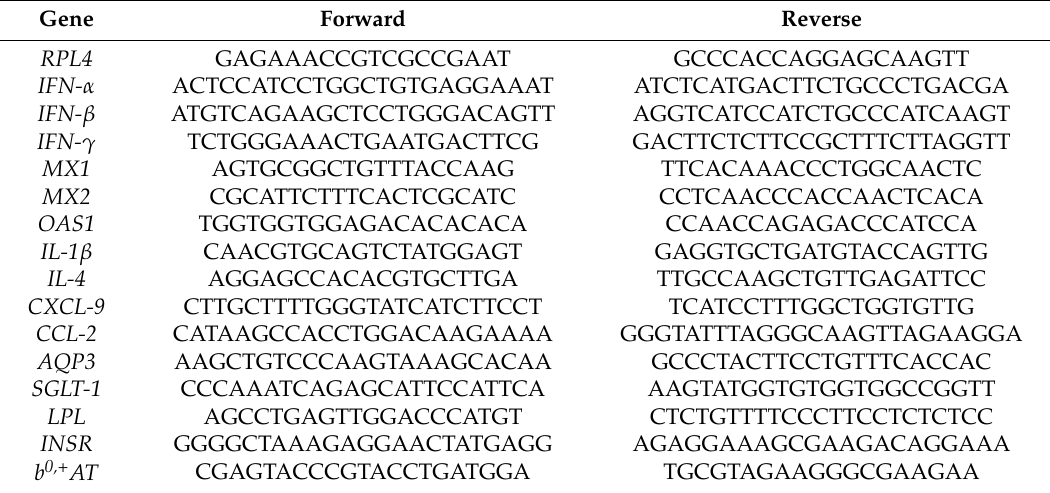
Table 7. Primers for real-time PCR